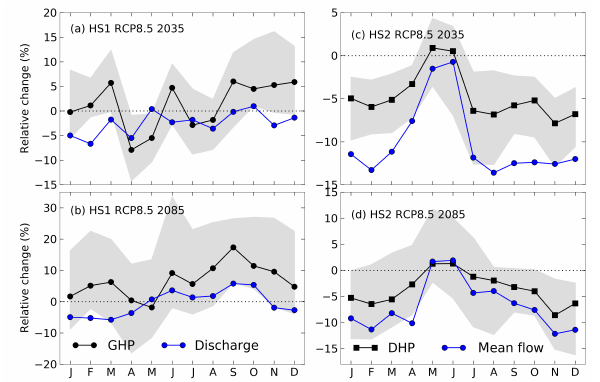
Figure 8. Relative changes in the monthly GHPs (DHPs) and dis- charges (reservoir inflow) in the hotspot regions for 2020–2050 (2035) and 2070–2099 (2085) under RCP8.5. HS1: the hotspot re- gion in southwest China (see Fig. 2); HS2: Sichuan and Hubei provinces (see Fig. 6). Grey areas denote the IQRs across the en- semble of GCM-GHM